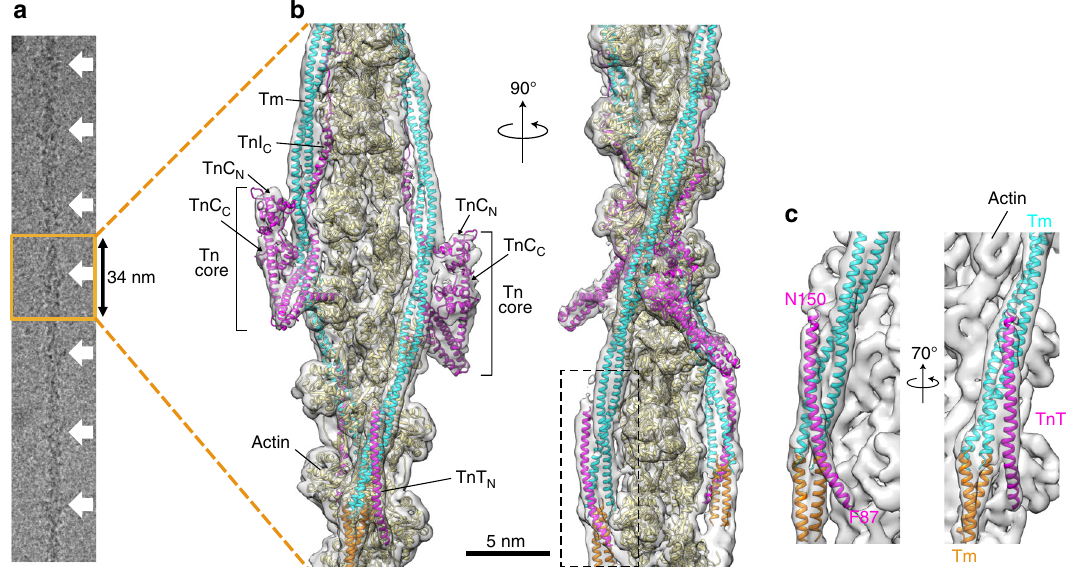
Fig. 1 Structure of human cardiac thin fi lament in the Ca 2 + free state. a a typical cryoEM image of the thin fi lament with periodic Tn binding along actin fi lament. b The model of the thin fi lament fi tted into the cryoEM density map in two different views. Approximately 12 actin subunits are shown with a pair of Tm coiled coils and a pair of the Tn ternary complexes consisting of the Tn core, TnI C extended upward from the core and TnT N attached closely to the head – tail junction of Tm near the bottom. c Magni fi ed images of TnT N complexed with the head – tail junction of Tm. The models are colored as: actin, beige; Tn, purple; and Tm, light blue and orange. Actin fi lament is oriented with its pointed end top including all the other fi